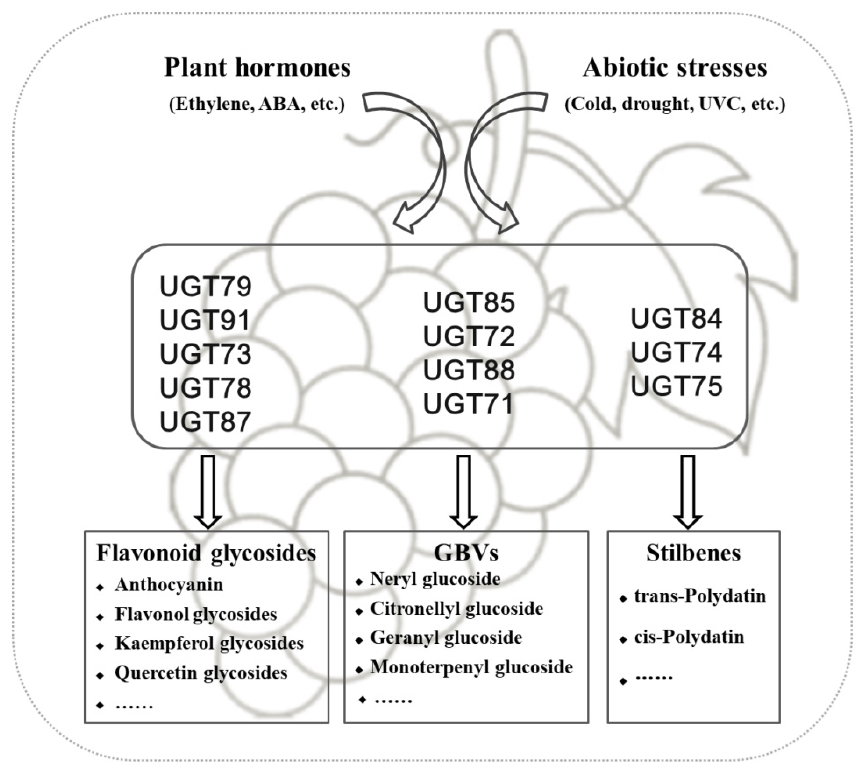
Figure 10. Model diagram for the synthesis and regulation of secondary metabolites related to fruit quality involved in UGT in grape fruits. When fruits are developed to a certain stage, the expression of different UGT members can be activated under the co-regulation of endogenous plant hormones and external environmental signals, thereby affecting the accumulation of secondary metabolites such as flavonoid glycosides, GBVs and stilbenes.